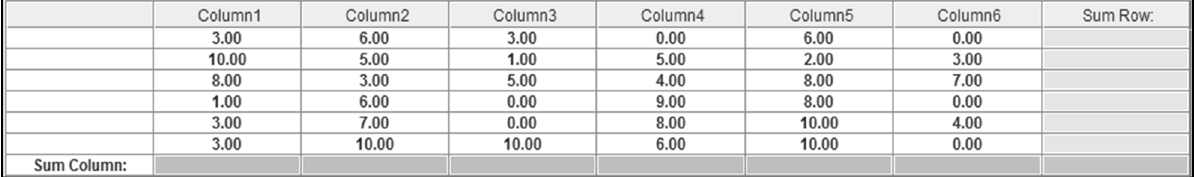
Figure 1. Sample work